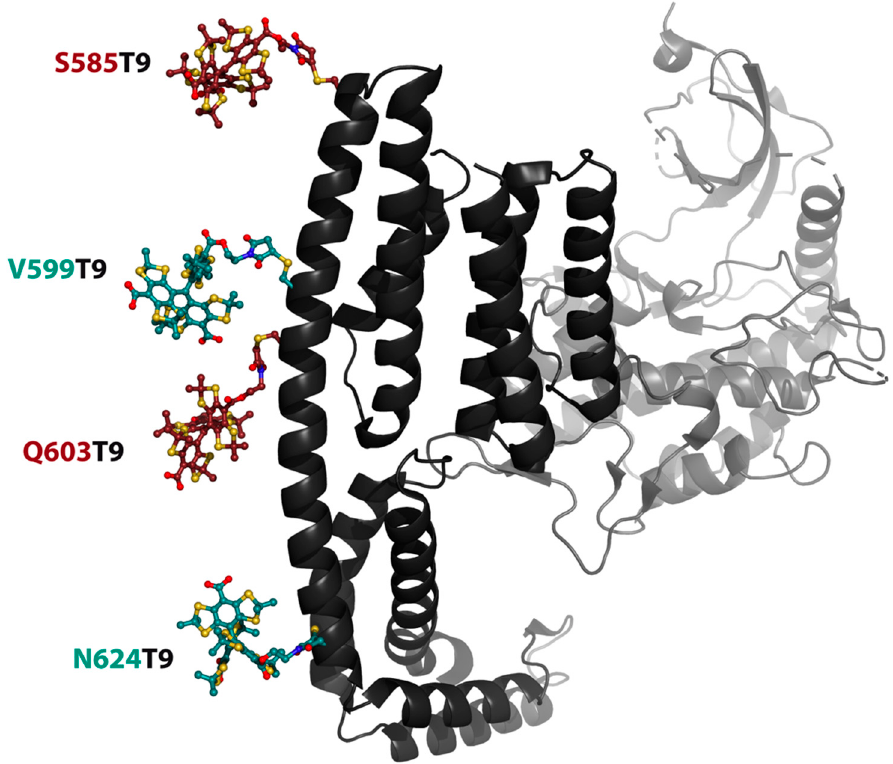
Figure 5. PyMOL cartoon representation of the GDI (front, black) and kinase domain (back, grey) of YopO (PDB-ID: 4ci6). The labeling positions on the GDI domain are indicated by color coded trityl pairs for the two studied mutants YopO S585C / Q603C (red) and YopO V559C / N624C (mint). For clarity reasons, only one conformer of T9 is displayed for each labeling site.